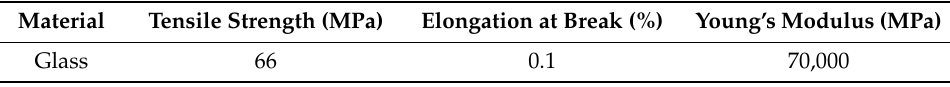
Table 2. Mechanical properties of glass according to literature